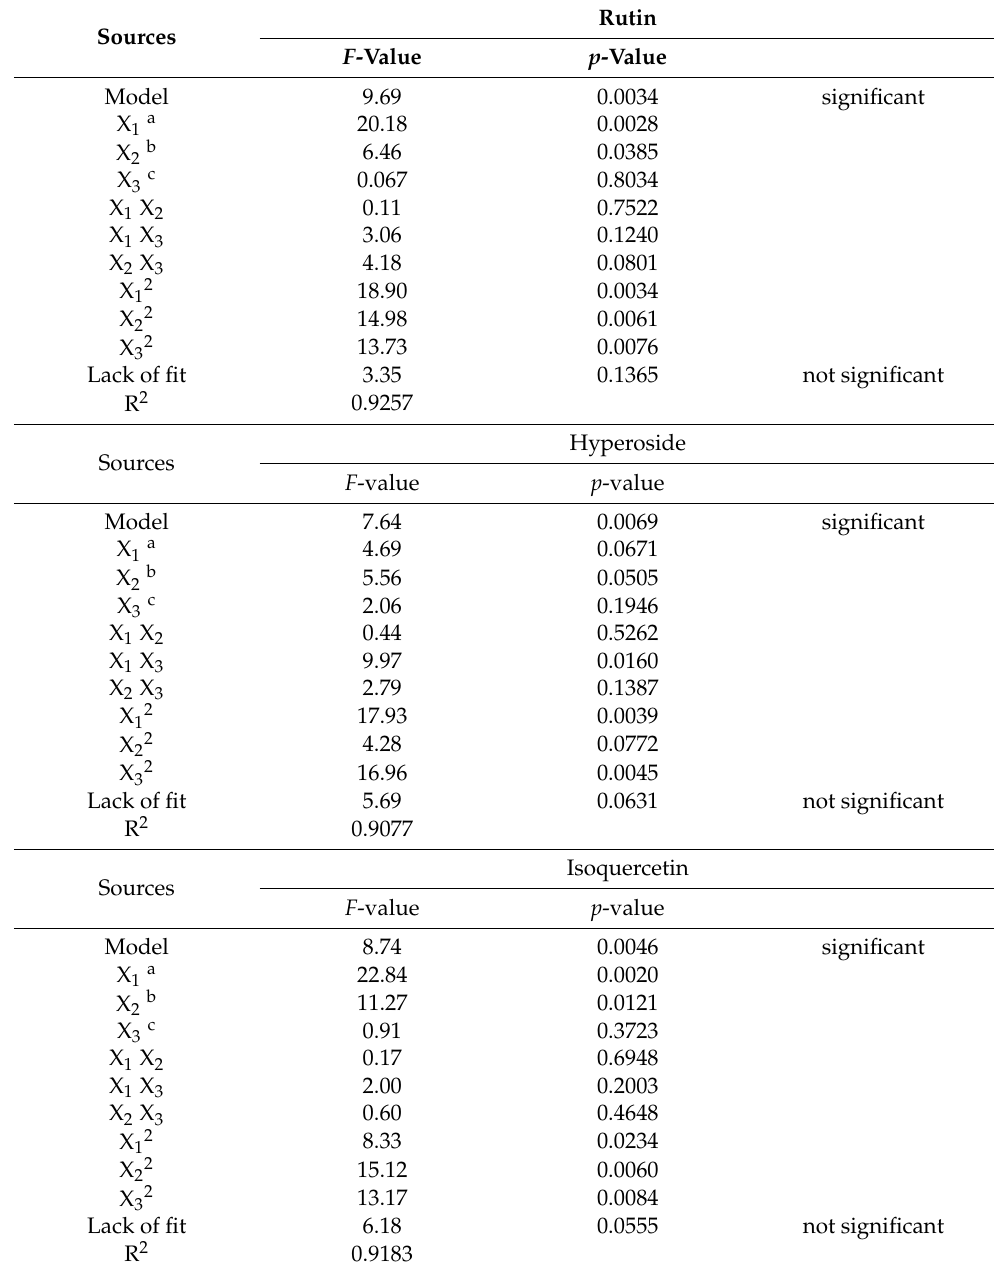
Table 5. ANOVA statistics of the model for extraction yields of rutin, hyperoside, isoquercetin, trifolin, astragalin, quercetin, and